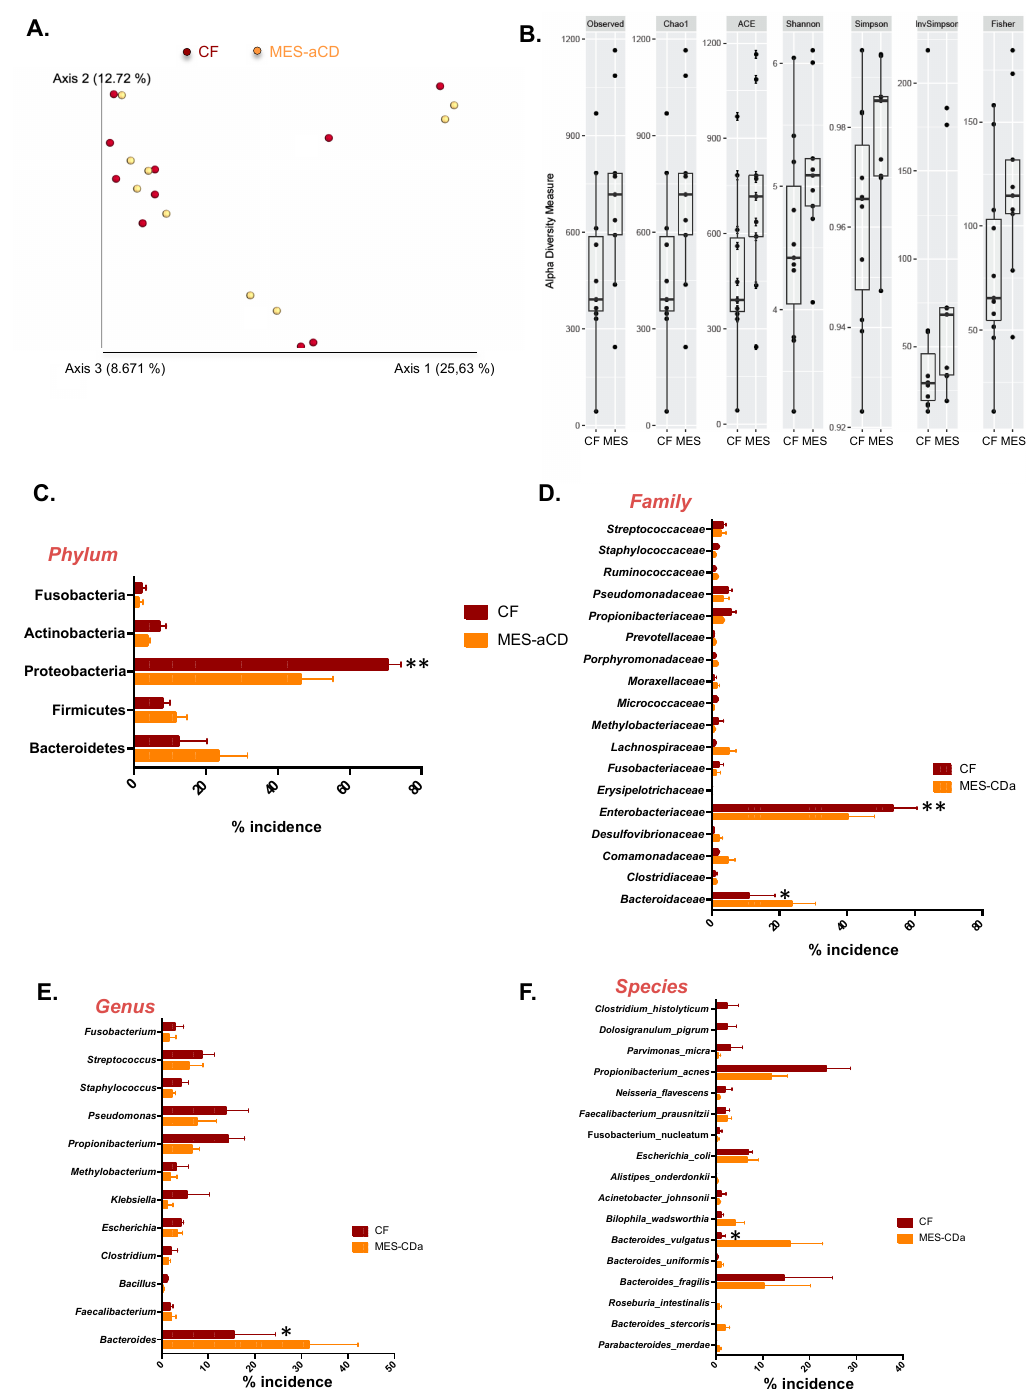
Figure 1. Visceral adipose tissue of patients with active Crohn’s disease contains bacterial DNA. (A) Weighted UniFrac principal coordinates analysis of microbiome data from creeping fat ‐ visceral adipose tissue ( CF ‐ VAT) and mesenteric ( MES ) ‐ VAT from eight patients with active Crohn’s disease (CD) revealed a similar pattern of clustering. ( B ) α -diversity indices (Observed, Chao1, ACE, Shannon, Simpson, InvSimpson, and Fisher) of the microbiomes of CF ‐ VAT and MES ‐ VAT. (C) Percentage of incidence of phylum, (D) family, (E) genus, and (F) species levels between CF ‐ VAT and MES ‐ VAT of CD patients. Data information: for B, data are represented in box ‐ and ‐ whisker plot format (whiskers: min to max). For C to F, values are expressed as mean ± SEM. Statistical analyses: Two-way analysis of variance with post hoc Bonferroni multiple comparisons test. *, p < 0.05; **, p <